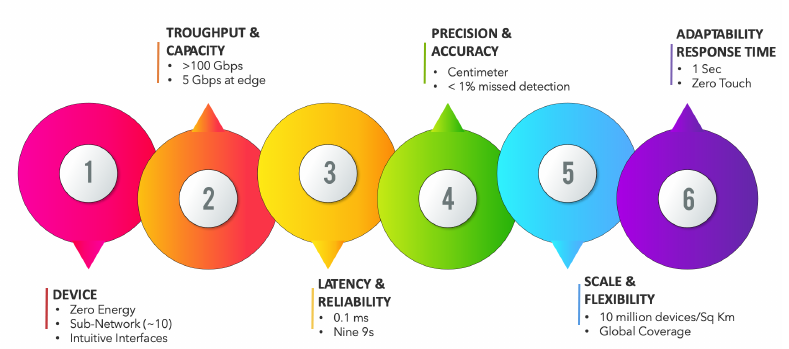
Figure 3. Key requirements and characteristics of